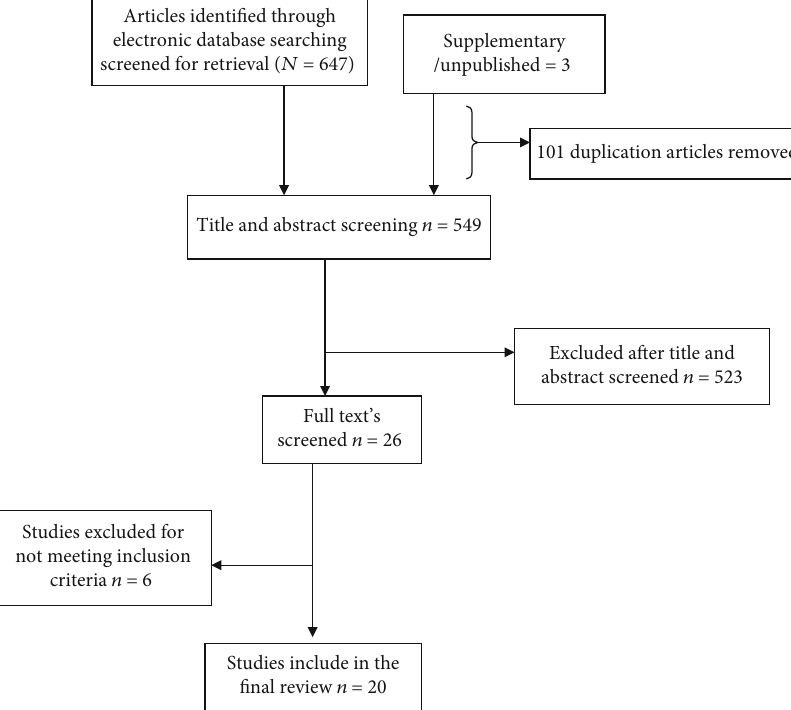
Figure 1: Flowchart shows selected and screening of articles for systematic review and